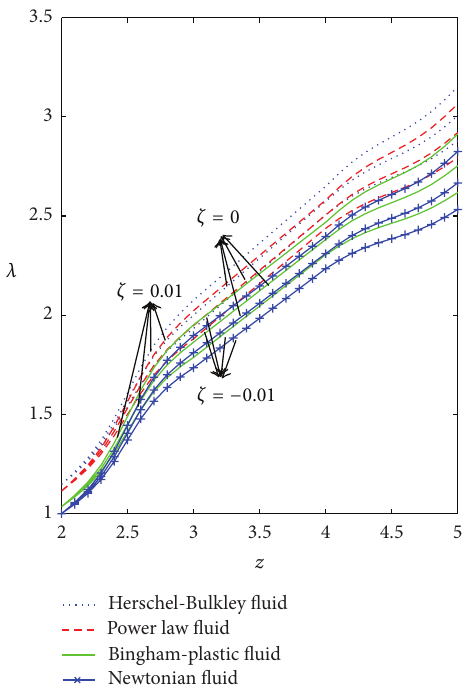
Figure 7: Variation of wall shear stress ( 𝜏 𝑤 ) with respect to axial distancefordifferentvaluesof 𝜏 𝑦 taking 𝑛 = 0.8 , 𝑘 = 1.4 ,and 𝛿 = 0.2 .